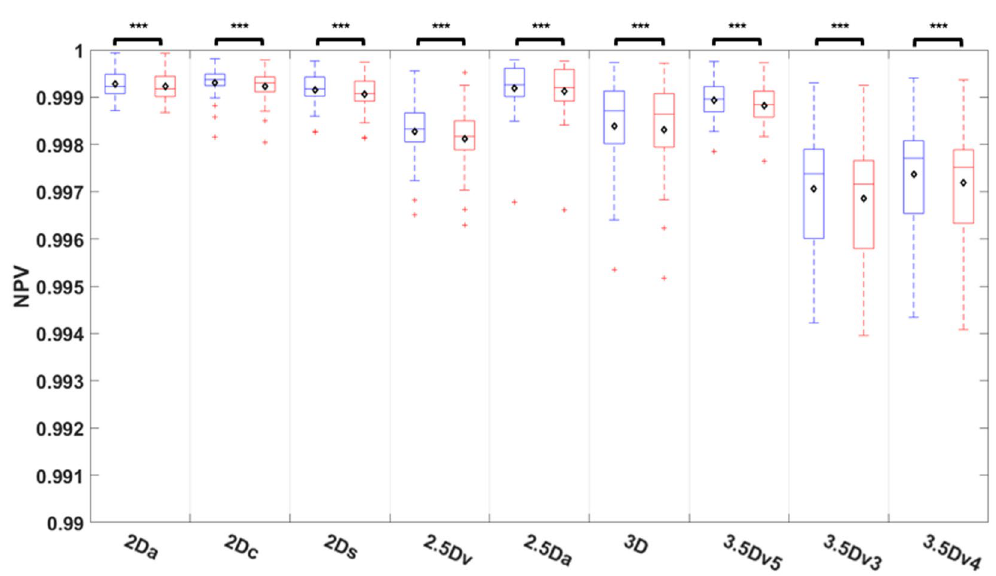
Figure 9. Comparison of negative predict value among 9 U-Nets before and after